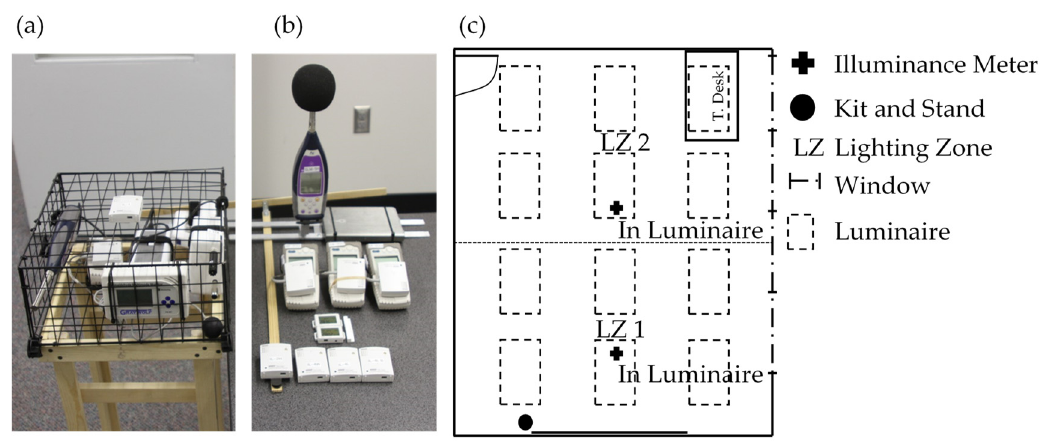
Figure 1. ( a ) Measurement Kit and Stand; ( b ) Additional Occupied Measurement Equipment; ( c ) Example Classroom Floor Plan.